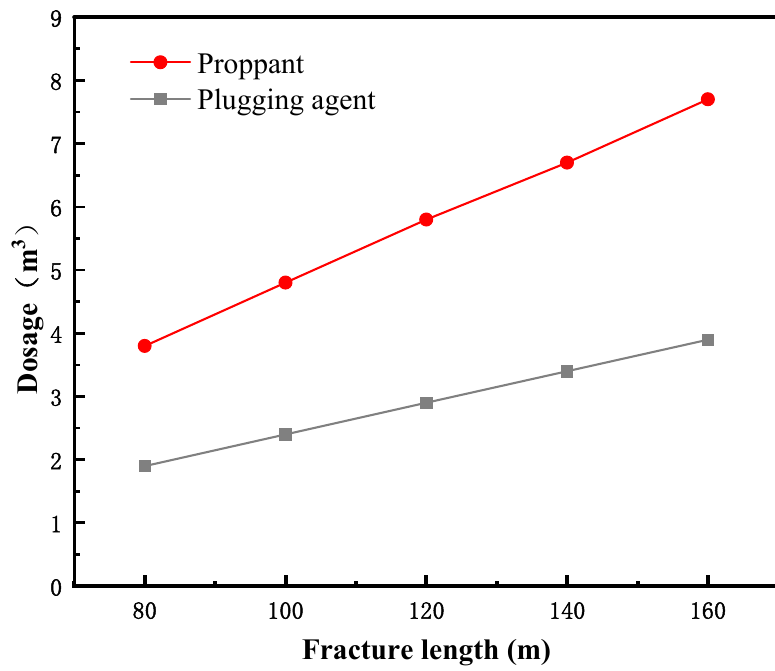
Figure 16. Plugging agent and proppant dosages for different fracture lengths.